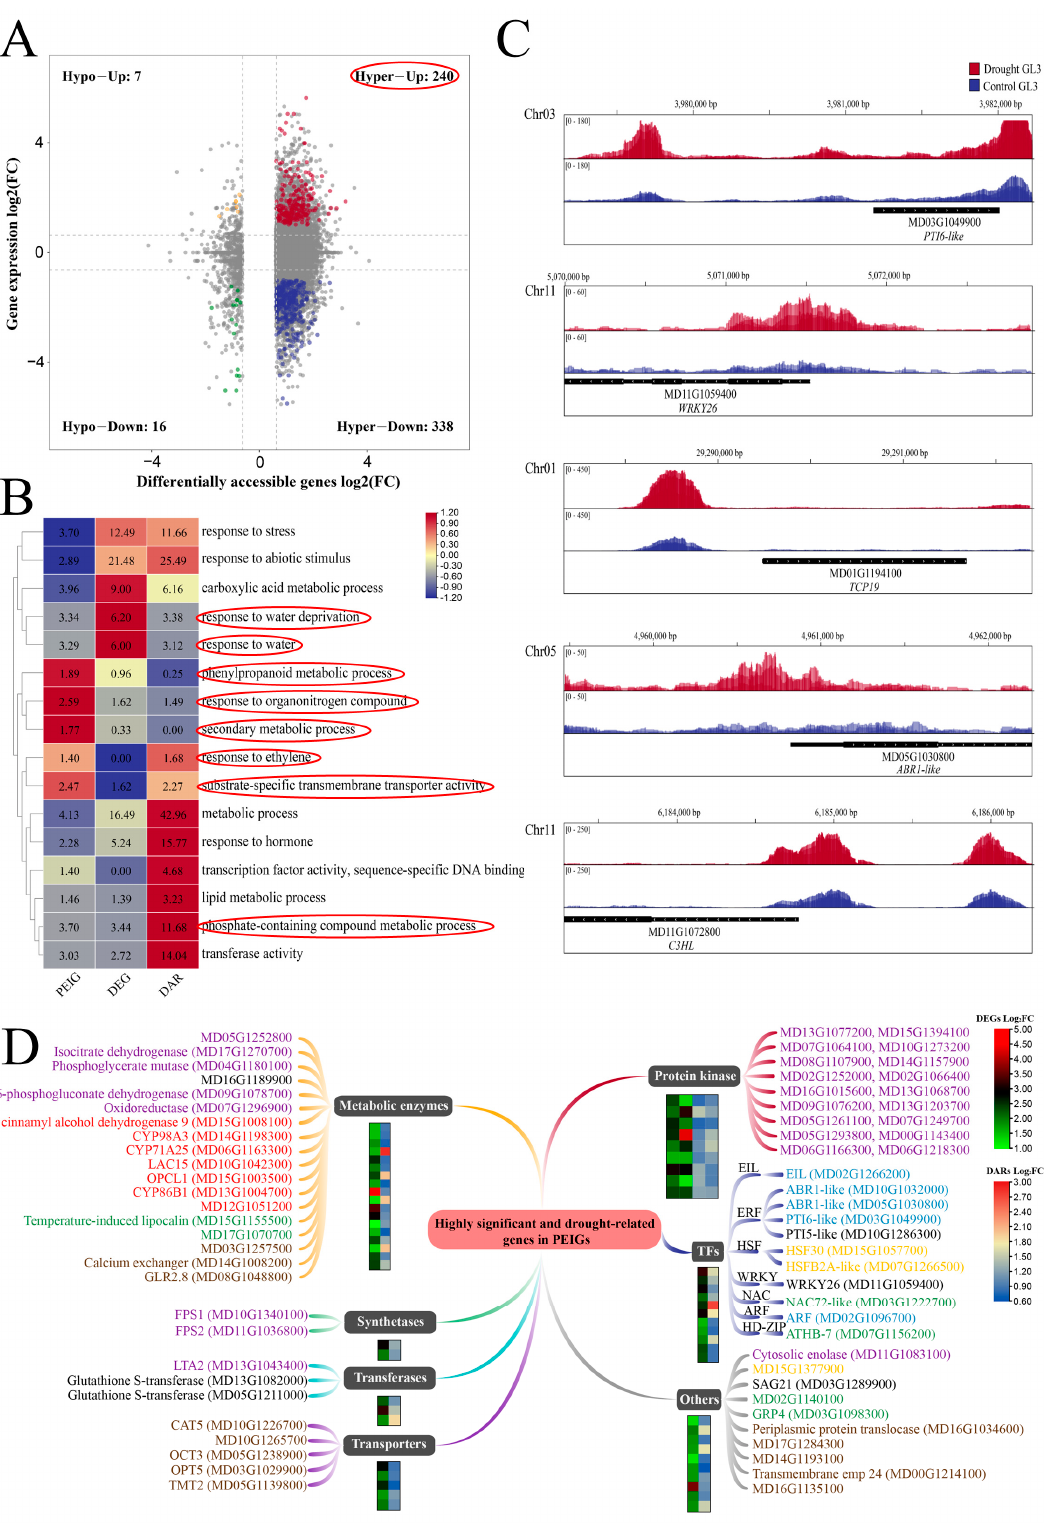
Figure 5. The association analysis of ATAC-seq and RNA-seq. ( A ) The pairwise comparisons of DEGs and differential ATAC-associated genes. The pathways marked with red boxes are used for further analysis in Figure 5D. ( B ) Functional enrichment of PEIGs compared with DEGs and DARs. Heatmap tagged with the number − log 10 (FDR). ( C ) ATAC signaling distribution in the upstream promoter region of related transcription factors in PEIGs. ( D ) Annotation of significantly enriched pathway genes in